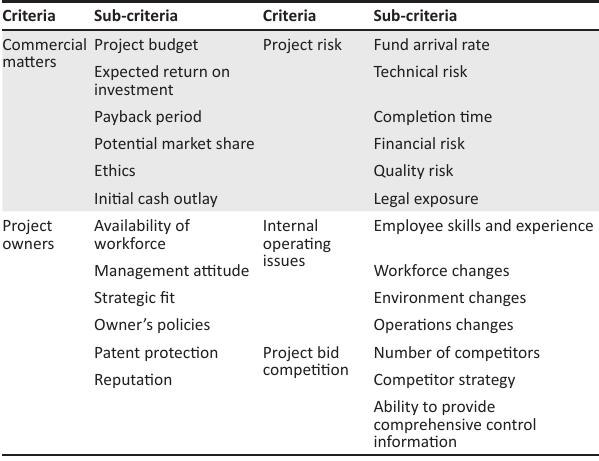
TABLE 2 : Examples of project evaluation